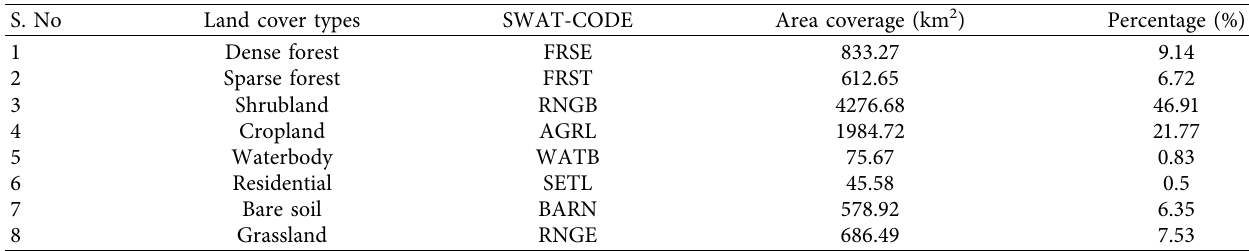
Table 4: Land use